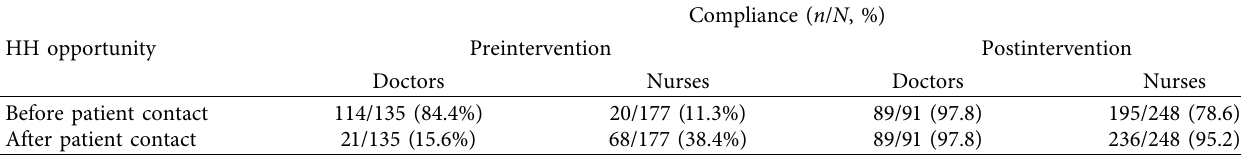
Table 6: Comparison of HH compliance before and after patient contact between doctors and nurses.